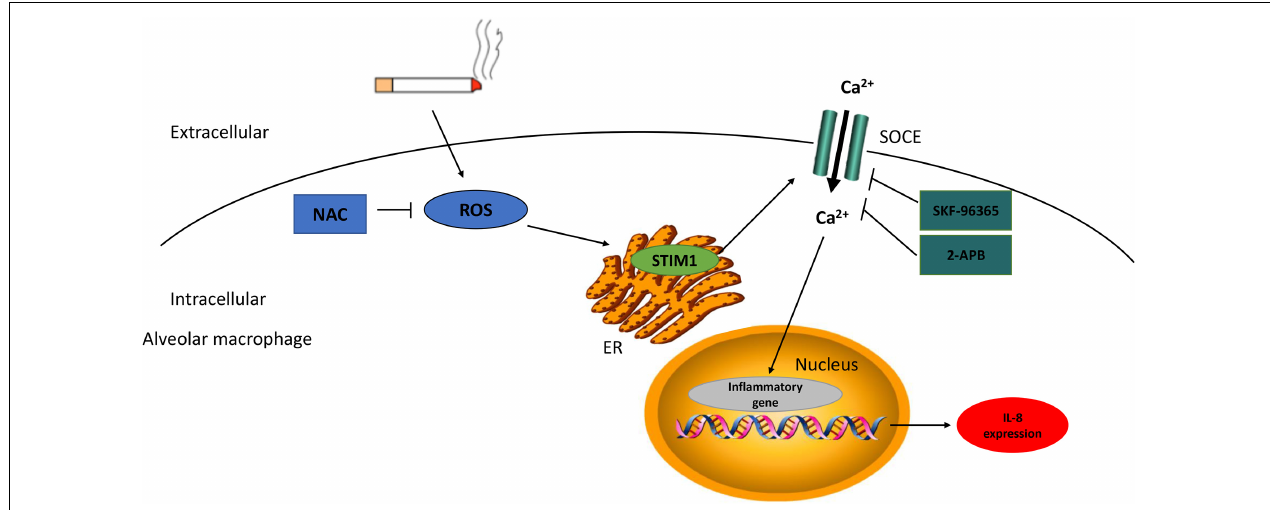
FIGURE 6 | The scheme diagram of STIM1 in the regulation of cigarette smoke (CS)-stimulated alveolar macrophage. CS-induced intracellular ROS production enhanced STIM1 expression in alveolar macrophage, and further promoted inflammatory cytokine secretion through the regulation of Ca2 + entry. NAC can alleviate intracellular ROS levels and SKF-96365/2-APB can dampen Ca2 + influx, both of which can mitigate the IL-8 expression. NAC, N-acetylcysteine; ROS, reactive oxygen species; STIM1, stromal interaction molecule 1; SOCE, store-operated Ca2 + entry; and ER, endoplasmic